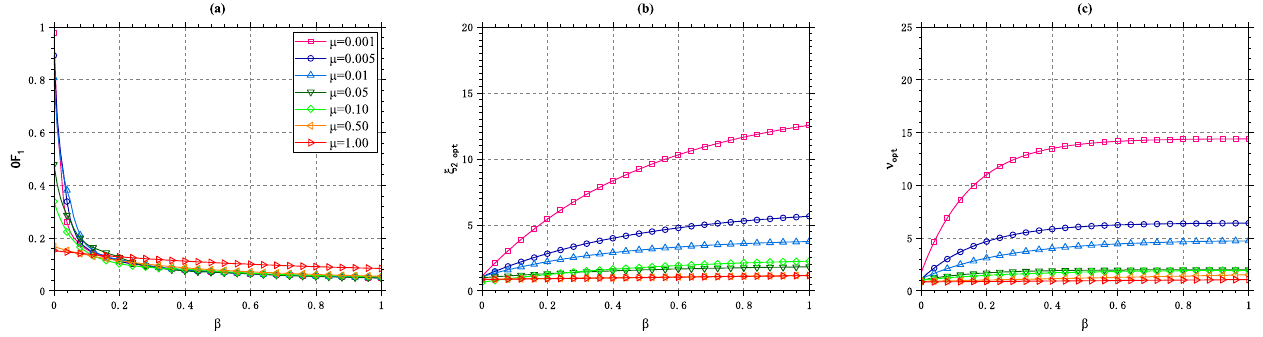
Figure 3. The minimum beam displacement variance σ 2 ( a ) and optimized design parameters for the damping ratio ξ 2 opt ( b ) and frequency ratio ν opt ( c ) for different mass ratios µ with parameter β .